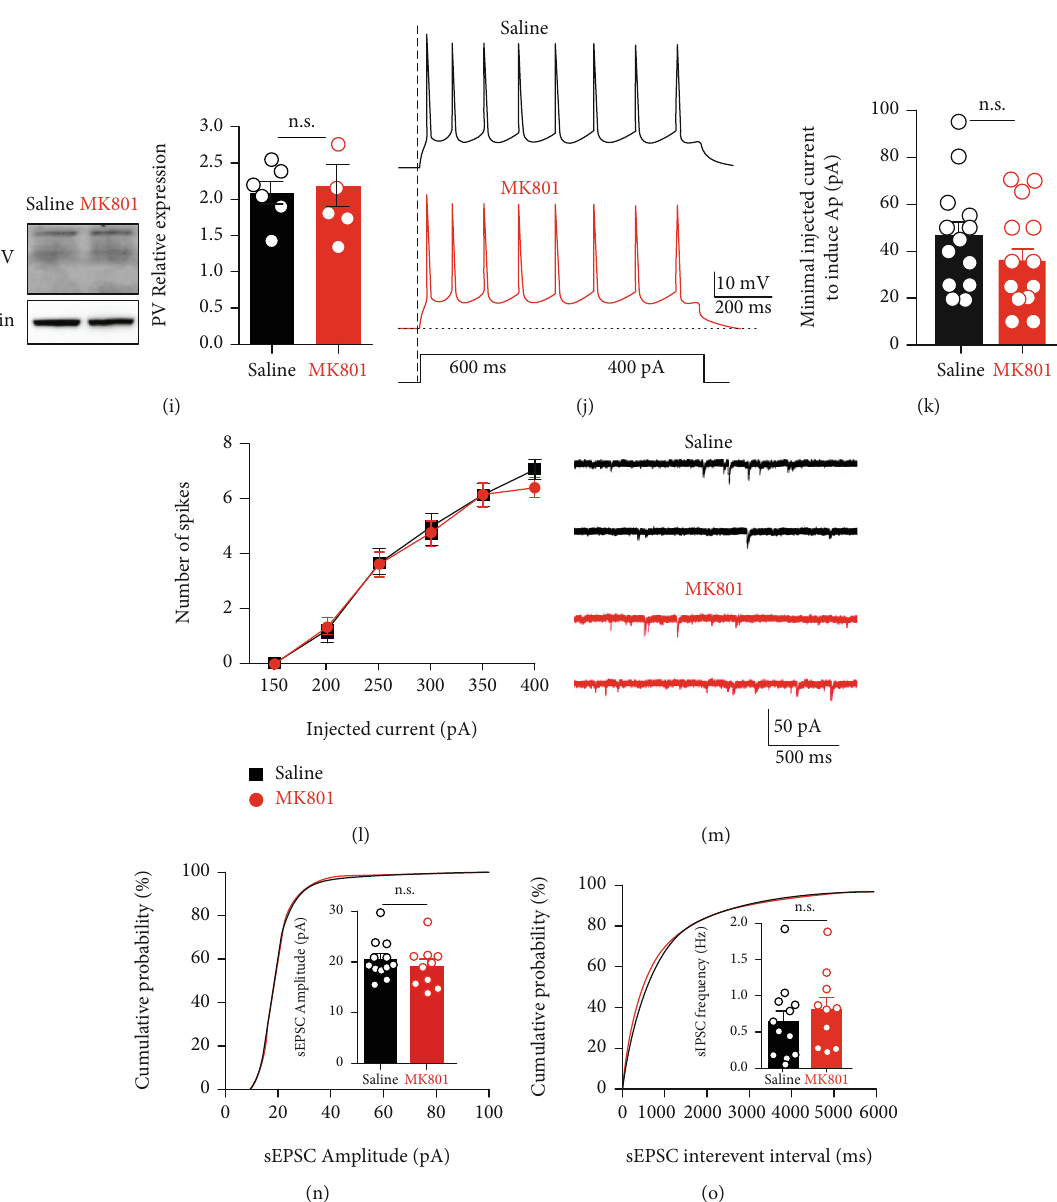
Figure 2: Electrophysiological recording of pyramidal neurons and PVIs + in the mPFC in adolescence. (a) Schematic diagram of whole-cell patch-clamp of sIPSC obtained from pyramidal neurons in the PrL region of mPFC. Saline or MK-801-treated mice were sacri fi ced on ~ PND 30 and subjected for electrophysiological recording. (b) Example traces of sIPSC in pyramidal neurons. (c) Cumulative probability and the average frequency of sIPSC (saline/MK801: n = 10/9 cells from 3/3 mice per group, ∗ p = 0 : 0224 ). (d) Cumulative probability and average amplitude of sIPSC (saline/MK-801: n = 10/9 cells from 3/3 mice per group, p = 0 : 5741 ). (e) Example traces of PVIs + response to depolarizing current steps. (f) Input-output curve showing the average fi ring rate of PVIs + in response to a series of increasing current steps. PVIs + in the MK-801 group fi red at an overall higher rate (two-way repeated-measures ANOVA, saline/MK-801: n = 8/9 cells from 4/3 mice per group, ∗ p = 0 : 0365 ). (g) Average action potential threshold of PVIs + (Student ’ s t -test: saline/MK-801: n = 8/9 cells from 4/3 mice per group, p = 0 : 7731 ). (h) Density of cells with PVIs + immunoreactivity in the PrL region. Student ’ s t -test: n = 8 for each group, p = 0 : 9477 . (i) Western blot analysis of PV immunoreactivity: n = 6/5 for the saline/MK-801 group. Student ’ s t -test, p = 0 : 7783 . (j) Example traces of pyramidal neurons in response to depolarizing current steps. (k) Average action potential threshold of pyramidal neurons (saline/MK-801: n = 13/15 cells from 3/4 mice per group, p = 0 : 2118 ). (l) Input-output curve showing the average fi ring rate of pyramidal neurons in response to a series of increasing current steps (two-way repeated-measures ANOVA, saline/MK-801: n = 13/15 cells from 3/4 mice per group, p = 0 : 5589 ). (m) Example traces of sEPSC in pyramidal neurons. (n) Cumulative probability and the average amplitude of sEPSC (saline/MK801: n = 12/10 cells from 4/3 mice per group, p = 0 : 4242 ). (o) Cumulative probability and the average frequency of sEPSC (saline/MK-801: n = 12/10 cells from 4/3 mice per group, p = 0 : 4544 ). Data were represented as mean ± SEM , ∗ p < 0 : 05 . Student ’ s t -test for two groups ’